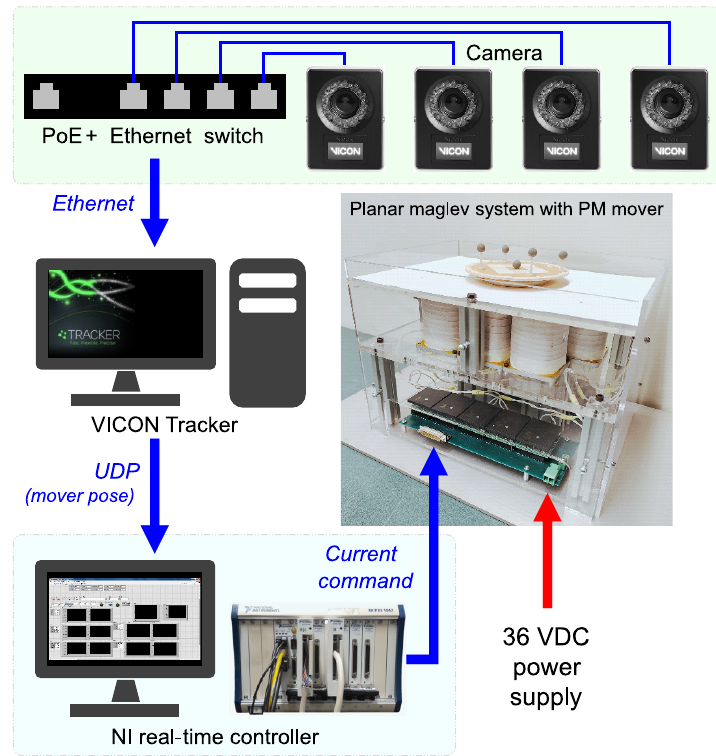
Figure 11. Overall system